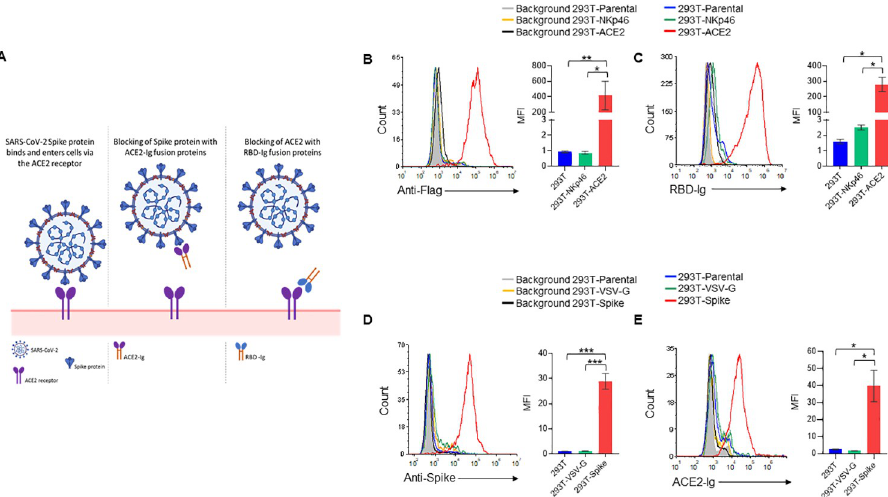
Binding of ACE2-Ig to SARS-CoV-2 Spike protein may prevent its binding to the ACE2 receptor thus blocking infection. (Right panel) Binding of RBD-Ig to the receptor ACE2 on host cells may prevent the binding of the spike protein thus blocking infection. This figure was created by us using BioRender. (B) Staining of 293T-ACE2, 293T-NKp46 and 293T parental cells using an anti-Flag antibody (left panel). Quantification of mean fluorescence intensity (MFI) of 3 repetitions (right panel). (C) Staining of 293T-ACE2, 293T-NKp46 and 293T parental cells with RBD-Ig (left panel). Quantification of MFI of 3 repetitions (right panel). (D) Spike protein surface expression on 293T cells co-transfected with either SARS-CoV-2 Spike envelope plasmid (293T-Spike cells) Vesicular stomatitis virus (VSV) G envelope plasmid (293T-VSV-G cells). 293T parental cells (untransfected) were also stained as a control (left panel). Quantification of MFI of 3 repetitions (right panel). (E) Staining of 293T-Spike/ 293T-VSV-G/ 293T parental cells with ACE2-Ig. Quantification of MFI of 3 repetitions (right panel). In all histograms except from those made for 293T parental cells, we gated on GFP positive cells. � p < 0.05, �� p < 0.01, ��� p < 0.001, Student’s t-test. Data are mean ± SEM of three independent